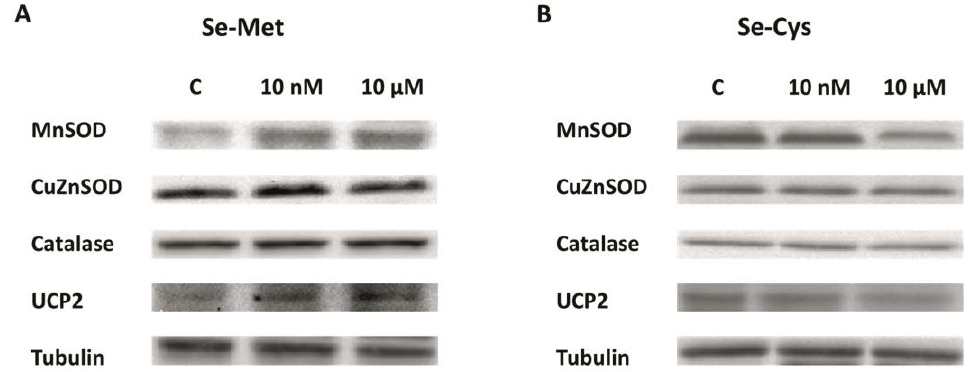
Figure 3. Western blot cropped representative bands of ( A ) selenomethione-treated and ( B ) selenocystine-treated MCF-7 breast cancer cell line are